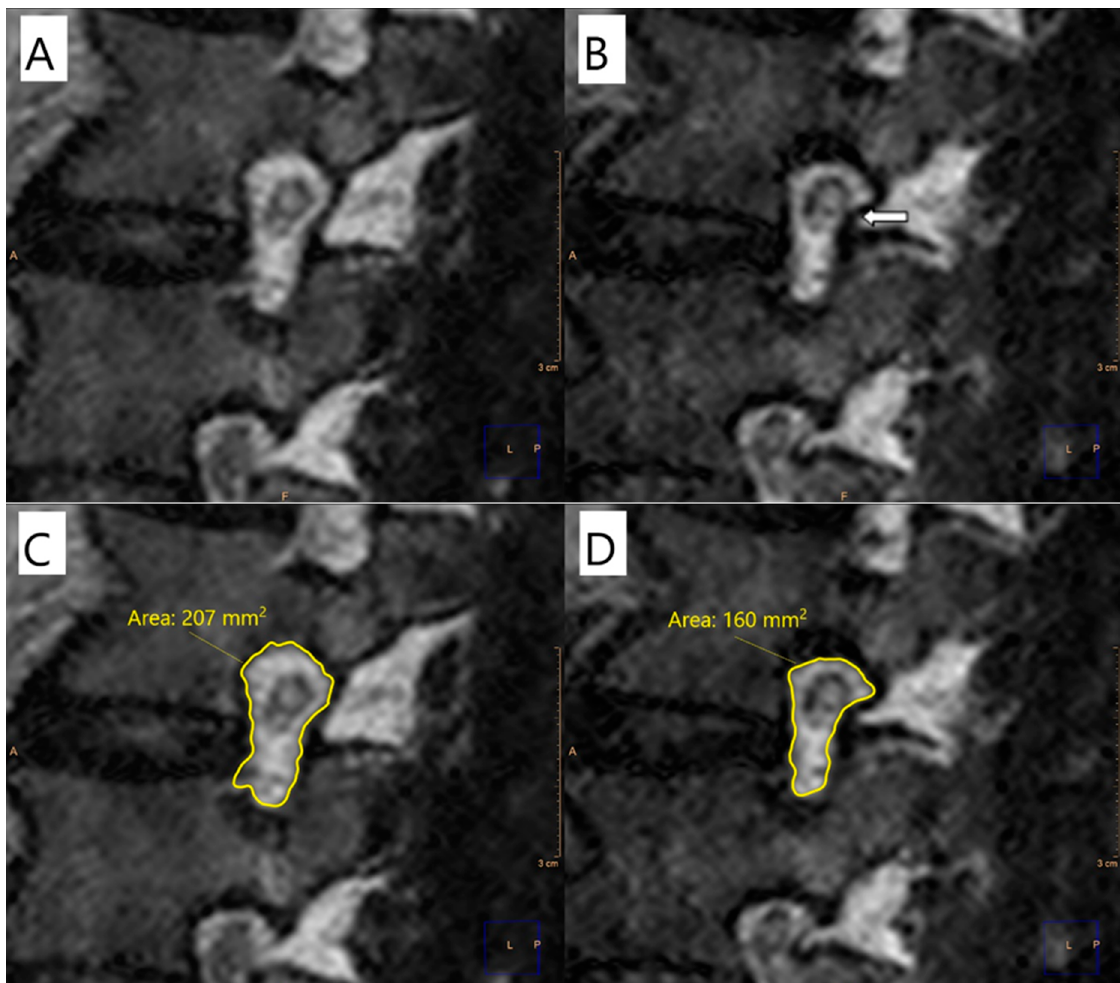
Figure 5. Sagittal magnetic resonance cross-section through the L2–L3 foramen. ( A ) Unloaded MRI shows normal relationships between the foramen and surrounding structures with no perineural fat obliteration nor root morphological changes; ( B ) axial-loaded MRI shows perineural fat obliteration surrounding the nerve root in the transverse direction (arrow); changes in the area of the intervertebral foramen at L2–L3 seen without ( C ) and with ( D ) axial loading.